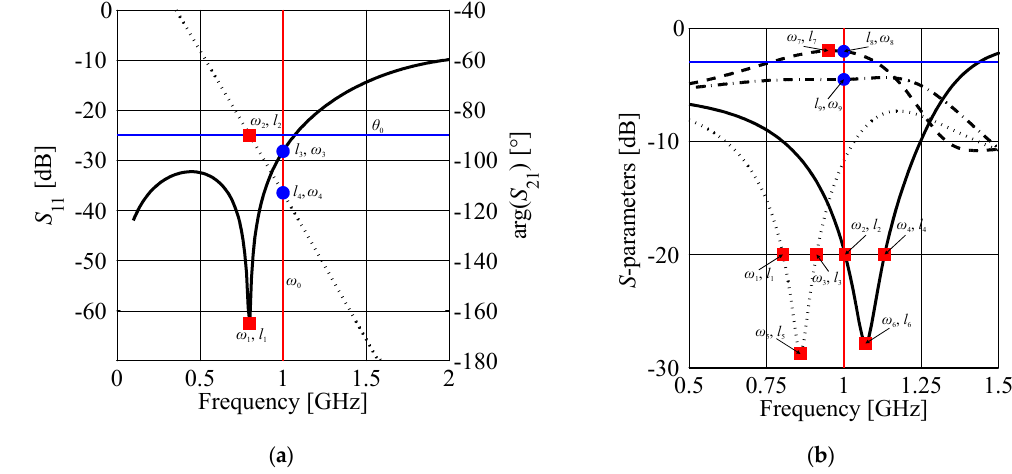
Figure 5. Surrogate model of individual CC – conceptual illustration. The correction layer parameters p = [ x c α ] T are adjusted in the course of parameter extraction process. Cell geometry and substrate parameters at the input port are maintained using x , x gap , and s parameters.